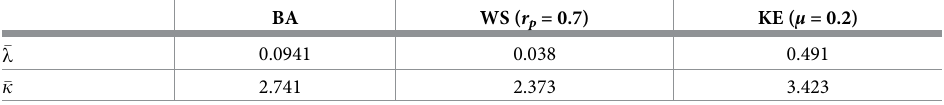
Table 1. � λ and � κ for the BA, WS, and KE models. In these simulations, we constructed 30 different networks for each model, and averaged the